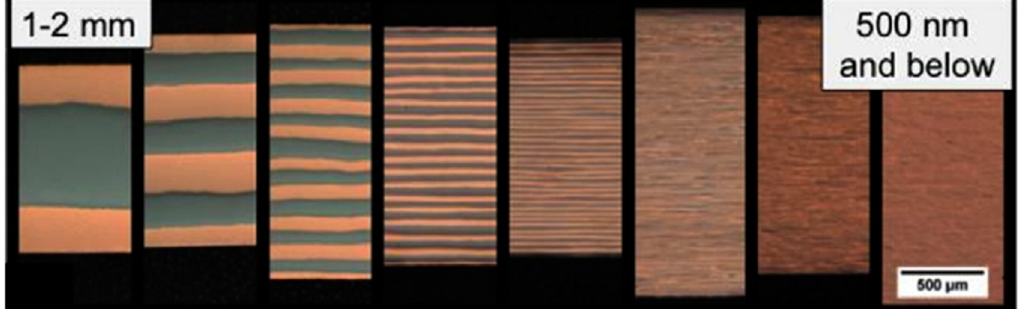
Figure 9. Multilayers manufactured using ARB with layer thickness ranging from millimeters to nanometers. Reprinted with permission from [64]; Copyright 2015 Elsevier; Reprinted with permission from [112]; Copyright 2013 Cambridge University Press.